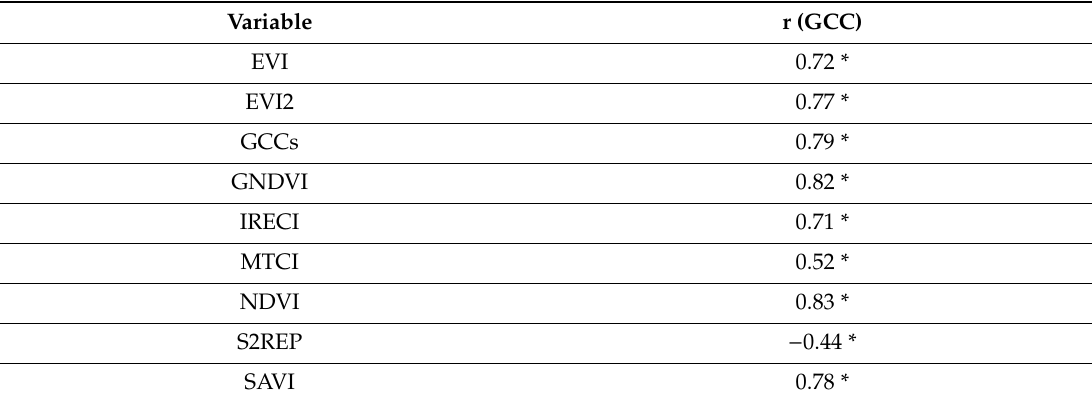
Table 2. Pearson correlation matrix between GCC data and the satellite VI on a daily scale. * p < 0.001.